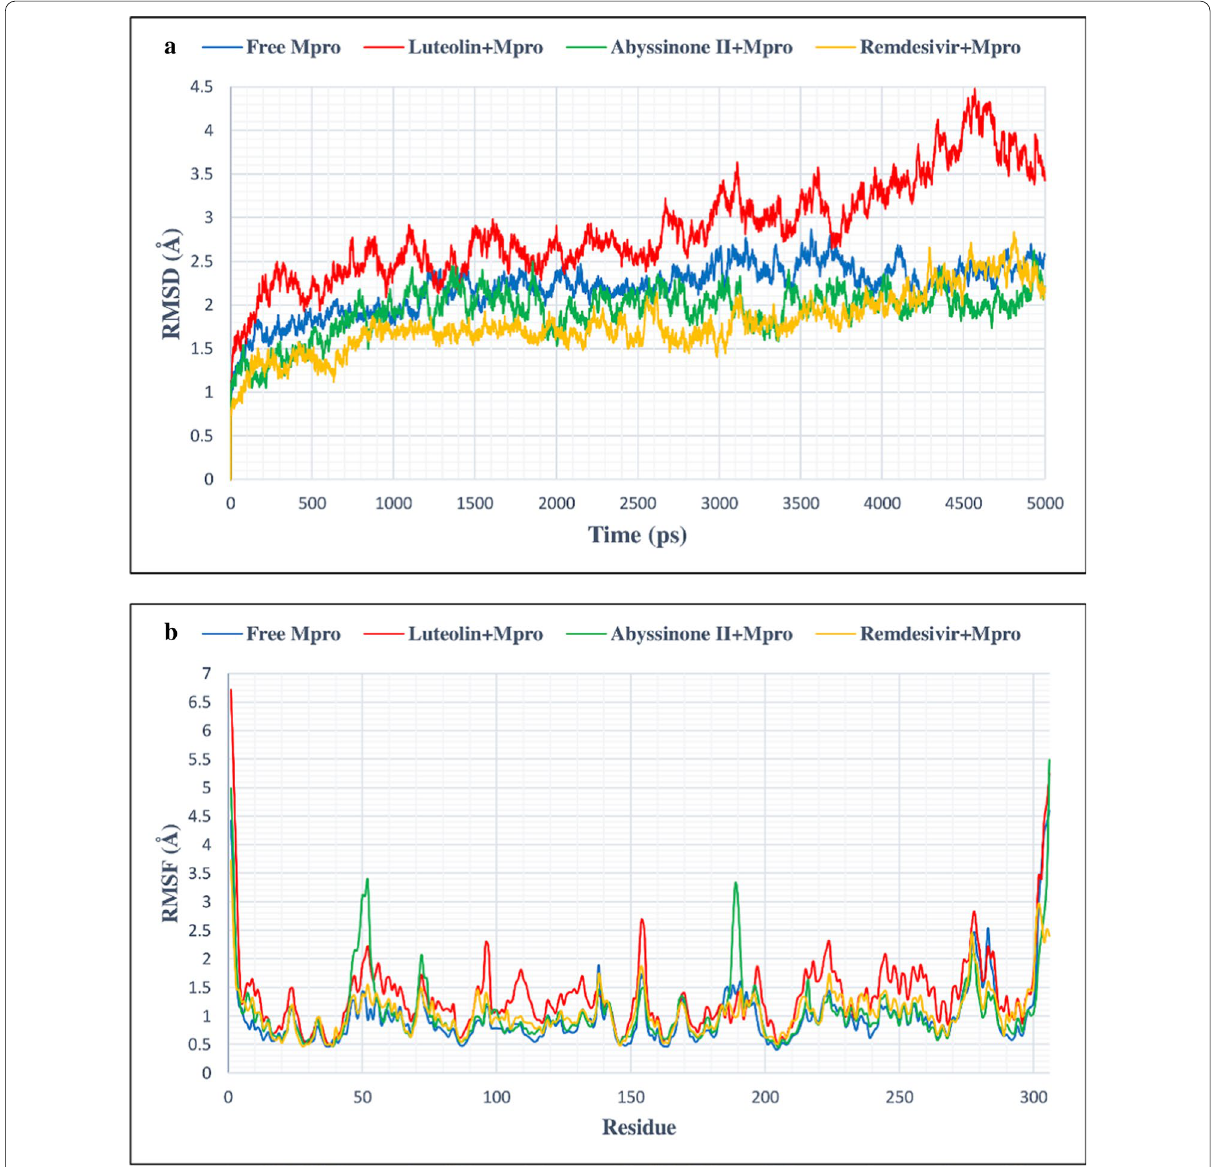
Fig. 6 a RMSD plot of 5 ns MD simulation for free and bound Mpro/3CLpro complexed with C3/luteolin, C43/abyssinone II and Con-2/remdesivir, b RMSF plot of free and bound Mpro/3CLpro complexed with C3/luteolin, C43/abyssinone II and